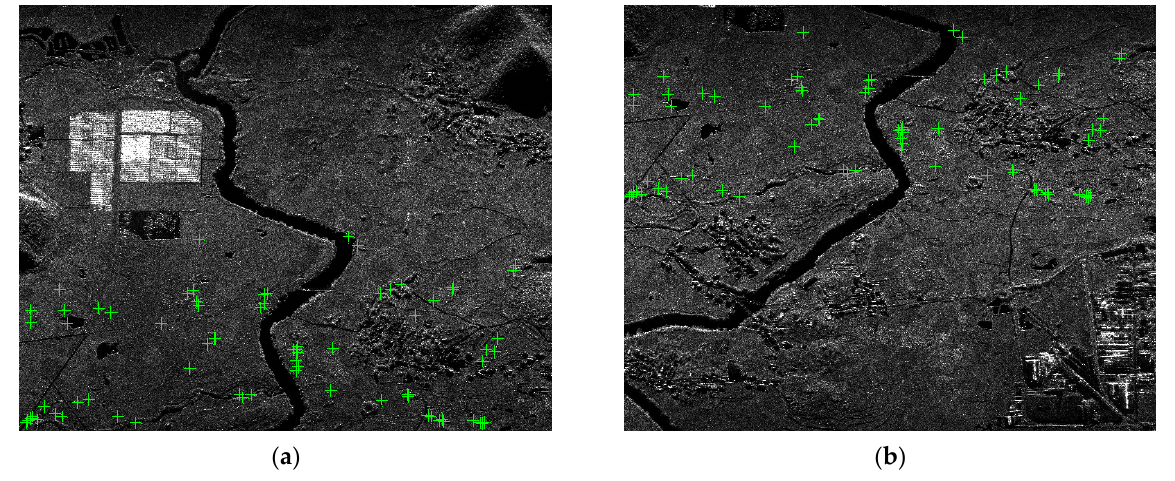
Figure 12. Location of tie-points in the adjacent SAR images between strips, where ( a ) is the master image and ( b ) is the slave image. The horizontal axes represent the azimuth direction, and vertical axes represent the slant range direction.